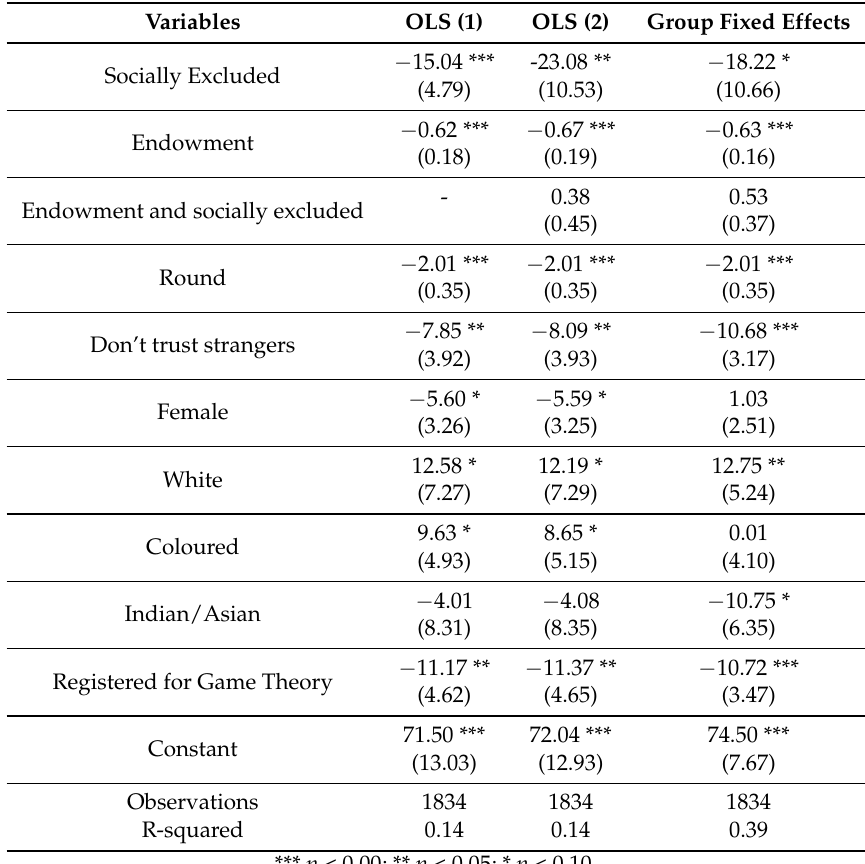
Table A2. Expanded Effects of Individual Social Exclusion.